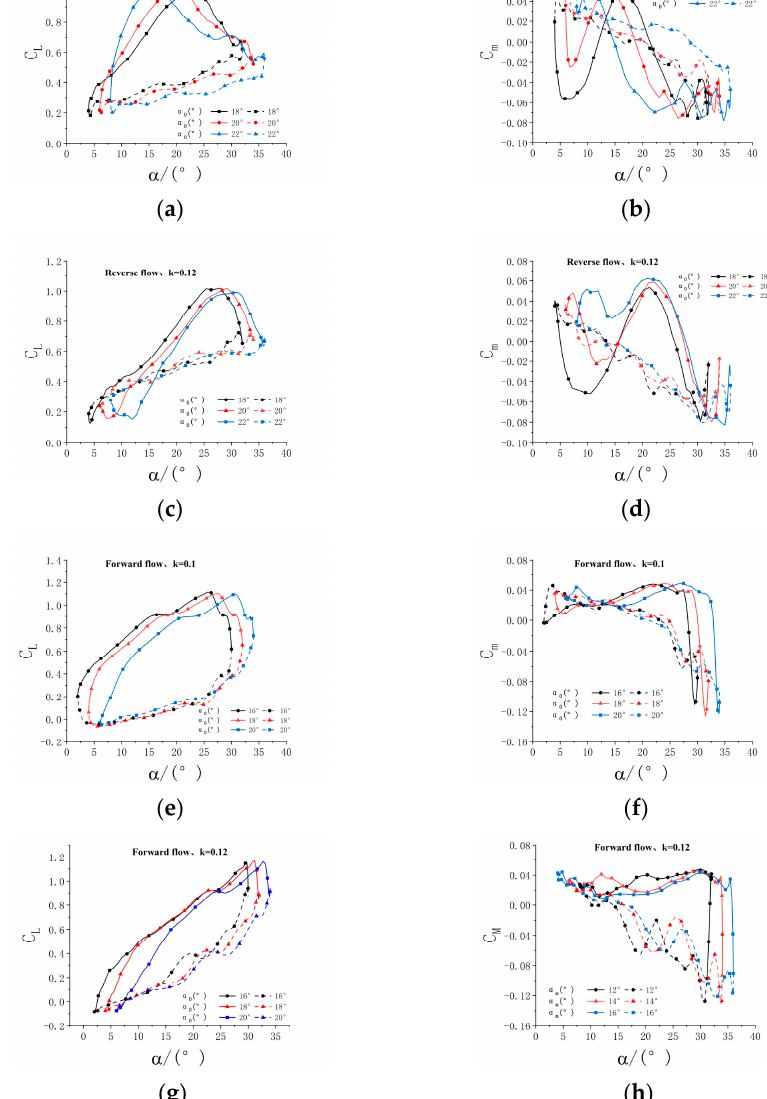
Figure 14. Effect of the mean angle of pitch at different K. ( a ) K = 0.1, C L , ( b ) K = 0.1, C m , ( c ) K = 0.12, C L , ( d ) K = 0.12, C m , ( e ) K = 0.1, C L , ( f ) K = 0.1, C m , ( g ) K = 0.12, C L , ( h ) K = 0.12, C m .